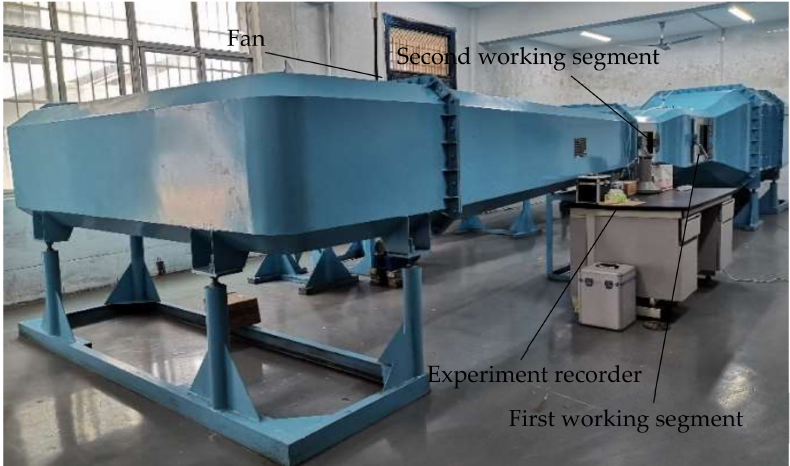
Figure 2. The annular wind tunnel.